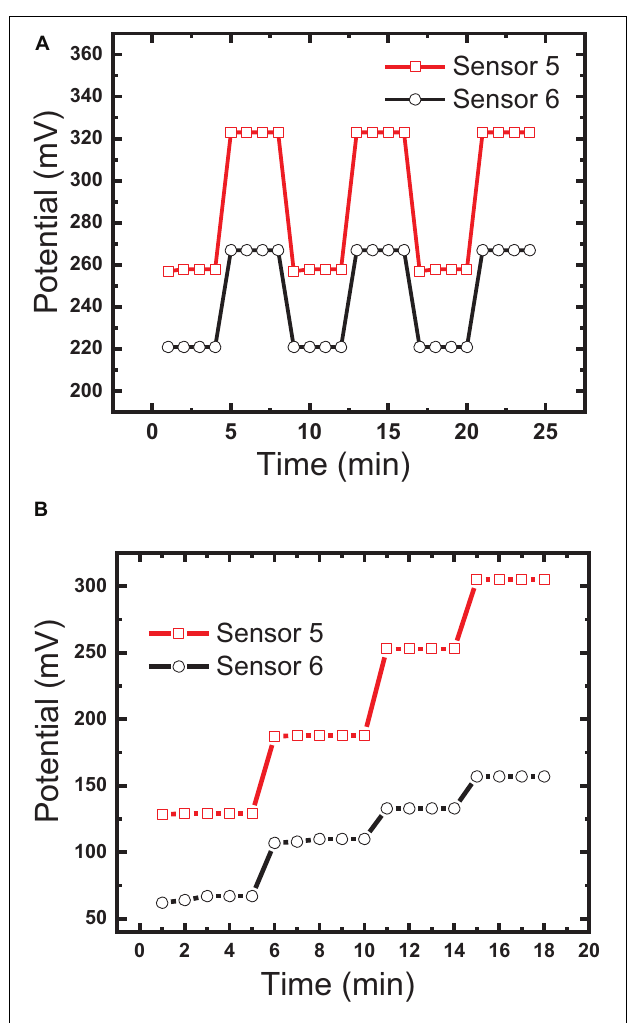
FIGURE 11 | Comparison between the constructed sensor: (A) sensor reversibility measured by forwarding and backwarding the electrodes between two different concentrations (10 − 5 , 10 − 6 M); (B) response time.